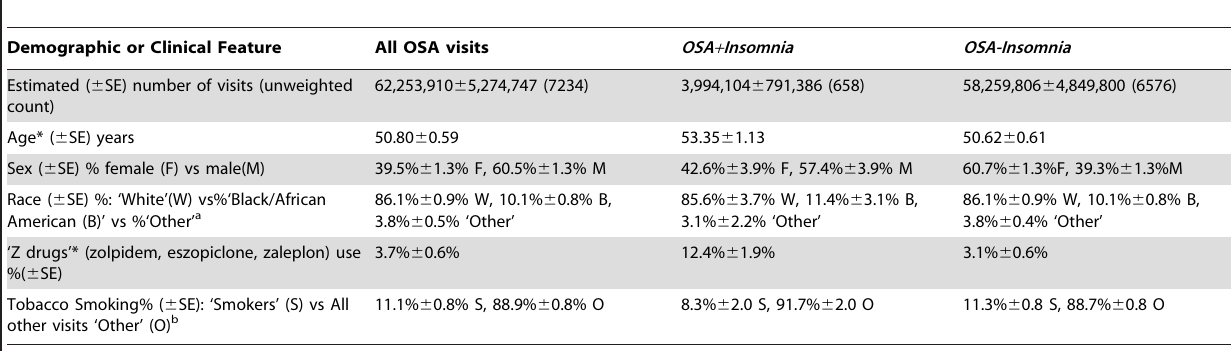
Table 1. Demographic and clinical features of the obstructive sleep apnea (OSA) sample.